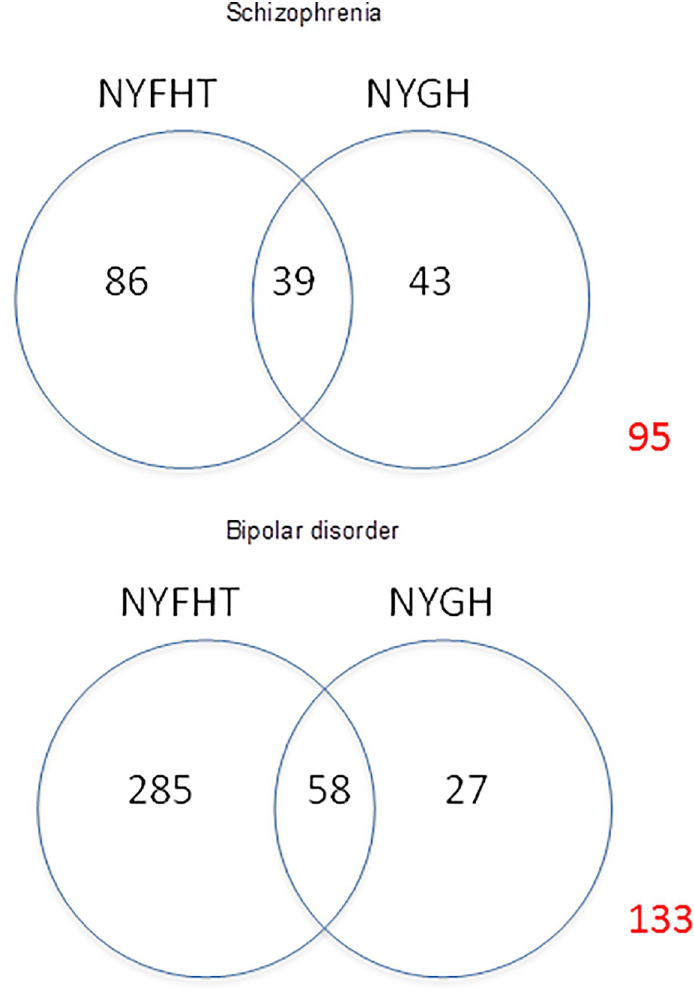
Fig 3. Estimate of total population of patients with schizophrenia and bipolar disorder in the Health Databank Collaborative database.